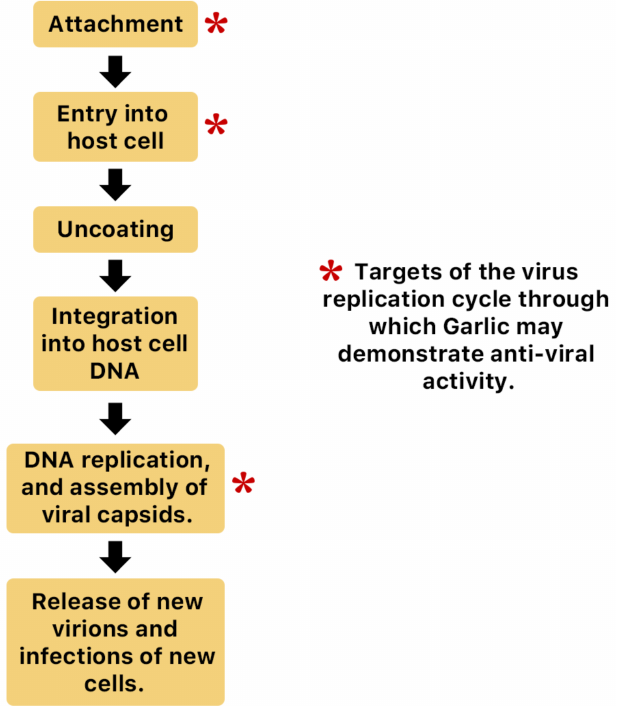
Figure 15. Possible anti-influenza mechanisms of garlic. Organosulfur compounds produced by garlic may inhibit various stages of the general virus life cycle including viral attachment, entry and multiplication [65]. Another possible mechanism of action is via inhibition of components of viral signaling pathways